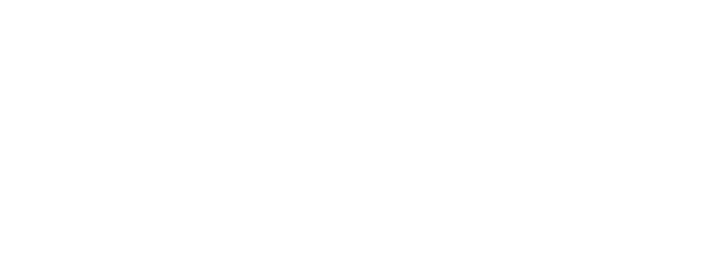
Table 1. Array ultrasonic transducer inspecting parameters.